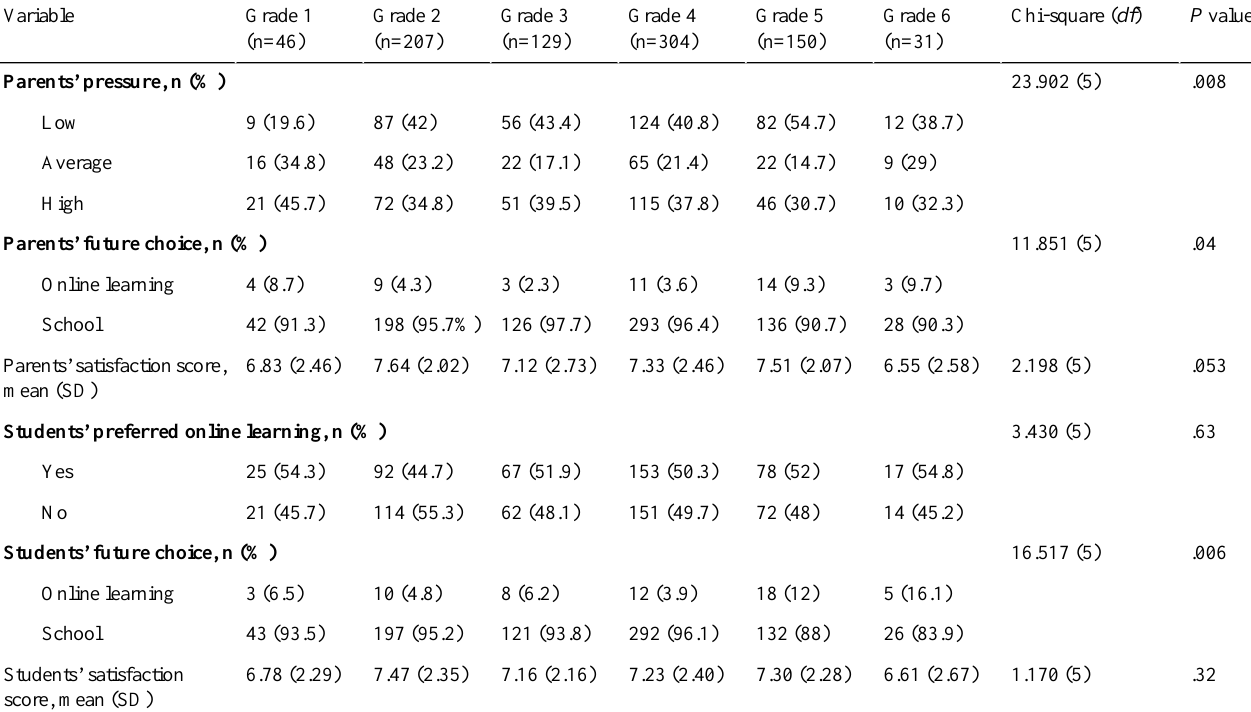
Table 2. Parents’perceived pressure from and satisfaction with online learning during the first stage (10-day mark) of this